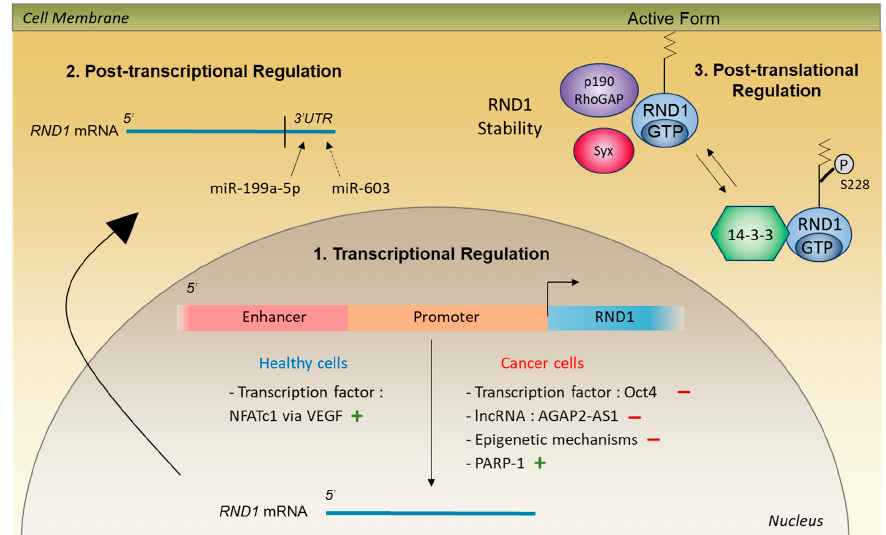
Figure 3. Regulation of RND1 protein in healthy and cancer cells. 1: RND1 transcription is regulated by diverse mechanisms. In healthy cells, the transcription factor NFATc1 increases RND1 transcription (marked as “+” in the figure). In cancer cells, the transcription factor Oct4, the lncRNA AGAP2-AS1 and epigenetic mechanisms, including DNA methylation and histone acetylation, act as repressors of RND1 transcription (marked as “ − ” in the figure) whereas PARP-1 stimulates RND1 transcription (marked as “+” in the figure). 2: RND1 expression is inhibited by the miRNAs miR-199a-5p and miR-603. The 3 (cid:48) UTR of RND1 mRNA has one or more specific binding sites for miR-199a-5p whereas the binding sites for miR-603 have not yet been identified. 3: RND1 protein is stabilized when it associates with its e ff ectors p190RhoGAP and Syx. When RND1 is phosphorylated, it binds to the 14-3-3 protein, which induces the translocation of RND1 from the plasma membrane to the